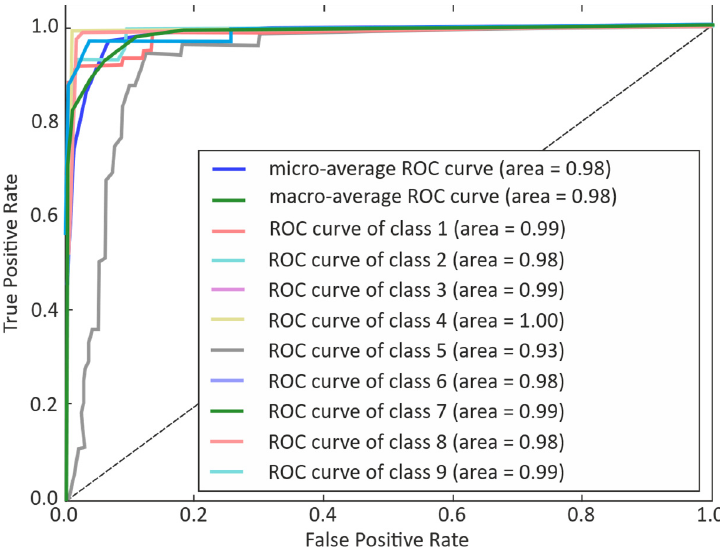
Figure 5. ROC plot for LR classifier (micro-averaged 99%).